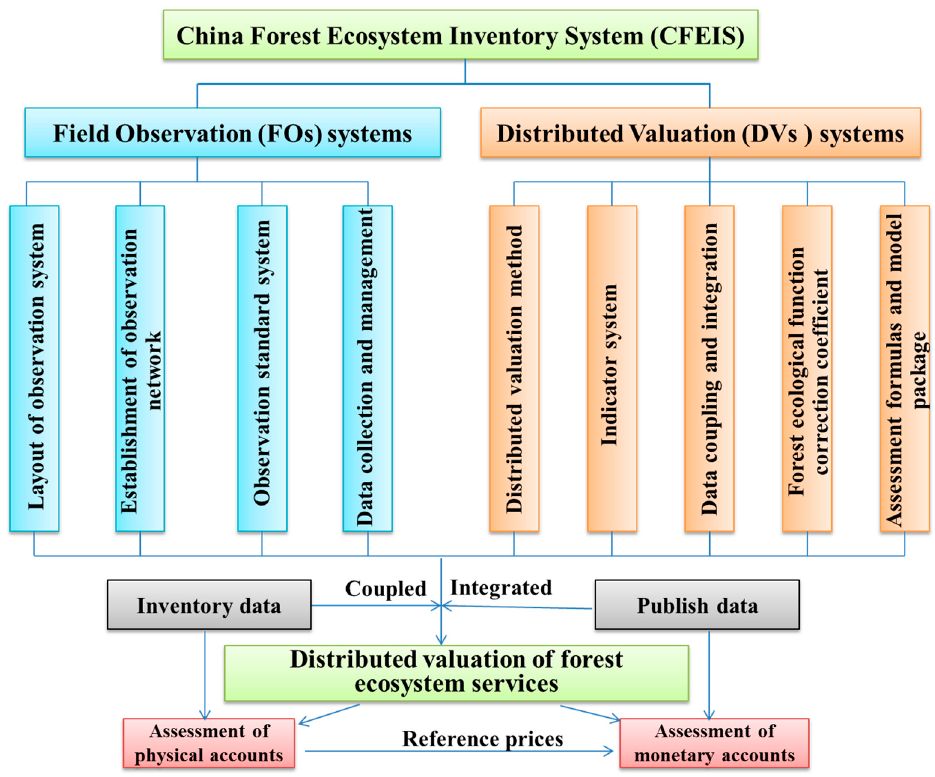
Figure 1. China Forest Ecosystem Inventory System (CFEIS) framework of Field Observation (FO) systems and Distributed Valuation (DV) systems showing data sources and coupling and integration of systems.